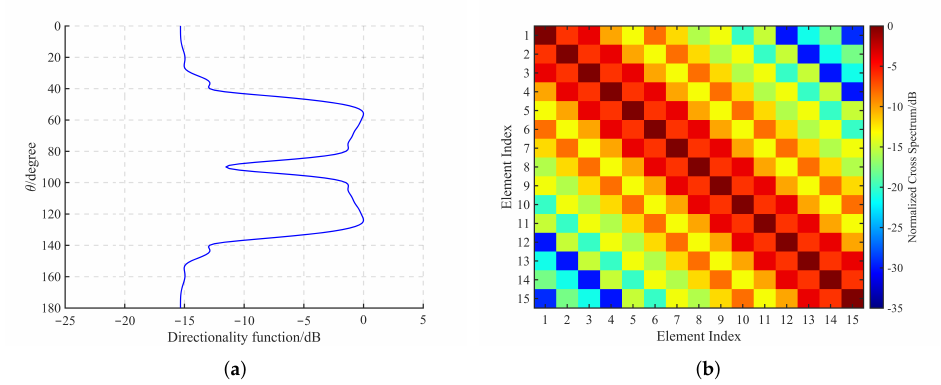
Figure 2. ( a ) The vertical directionality and ( b ) the normalized CSM of the wind-generated noise at 750 Hz in shallow water.